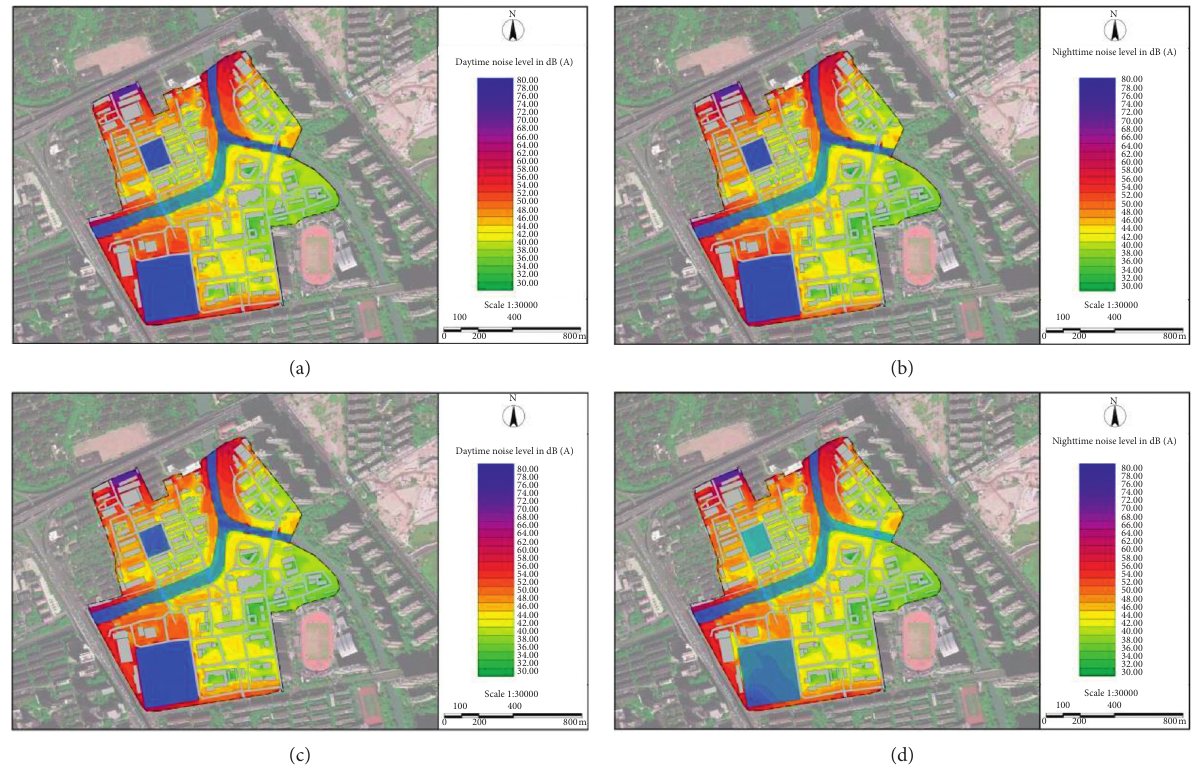
Figure 8: Simulation results of the campus of Zhejiang University of Technology with noise barrier optimisation: (a) weekdays daytime, (b) weekdays nighttime, (c) weekends daytime, and (d) weekends